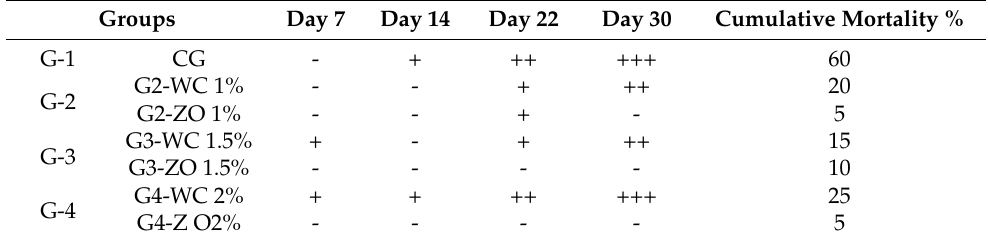
Table 5. Clinical observation of the infections.